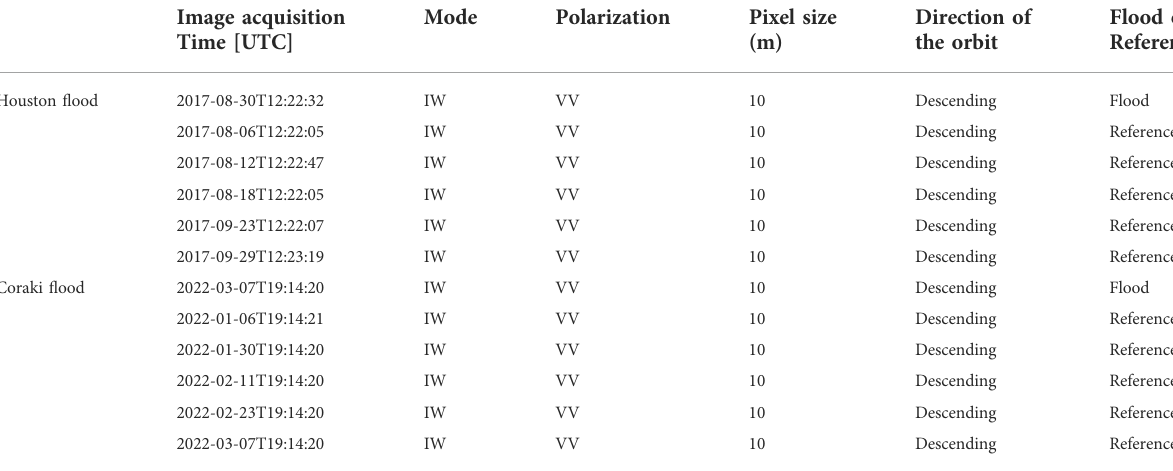
TABLE 1 The selected Sentinel-1 satellite datasets for Houston fl ood and Coraki fl